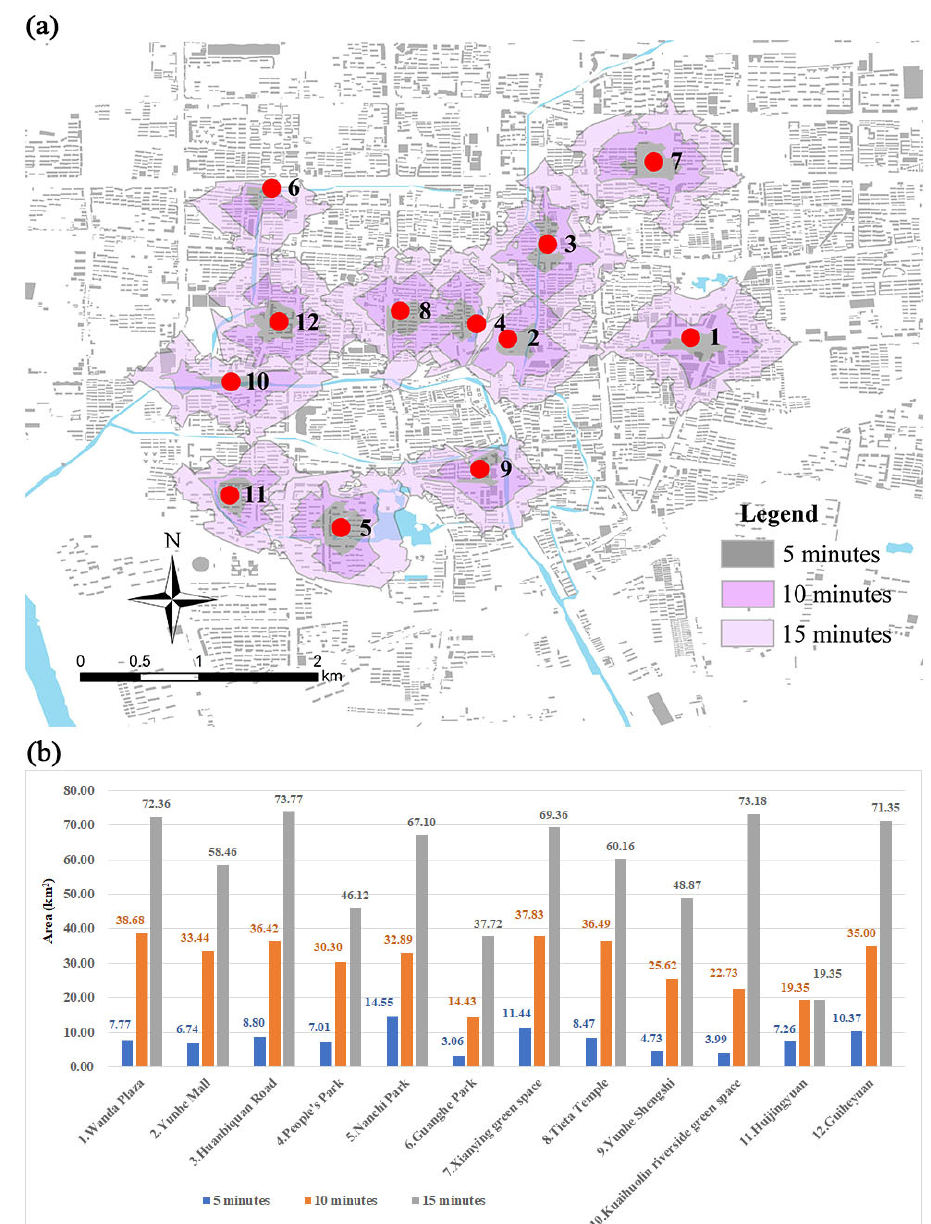
Figure 4. ( a ) Walking accessibility analysis of 12 sample points. ( b ) Comparison of areas of 12 sample points according to 5-, 10-, and 15-minute walking